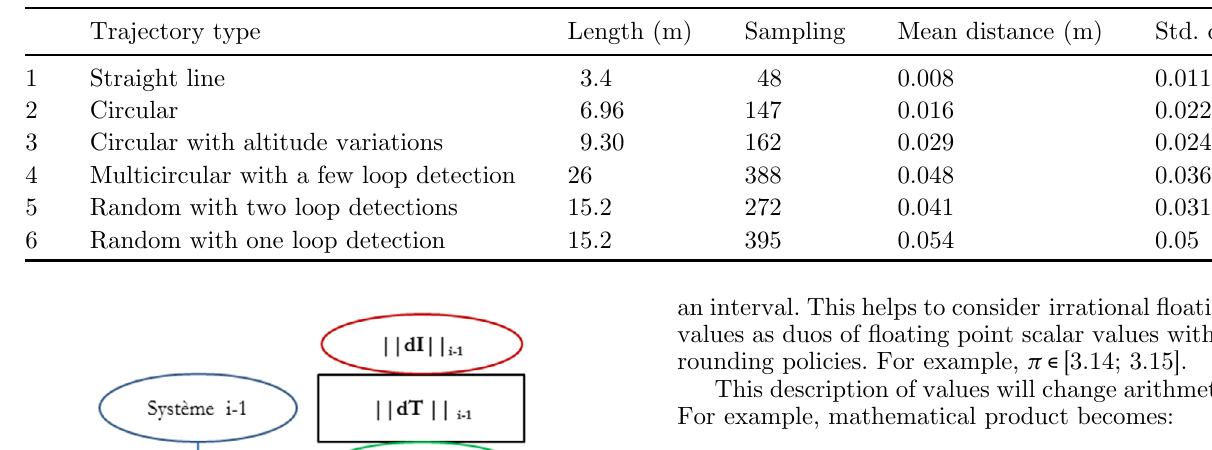
Table 2. Trajectory reconstruction comparison.